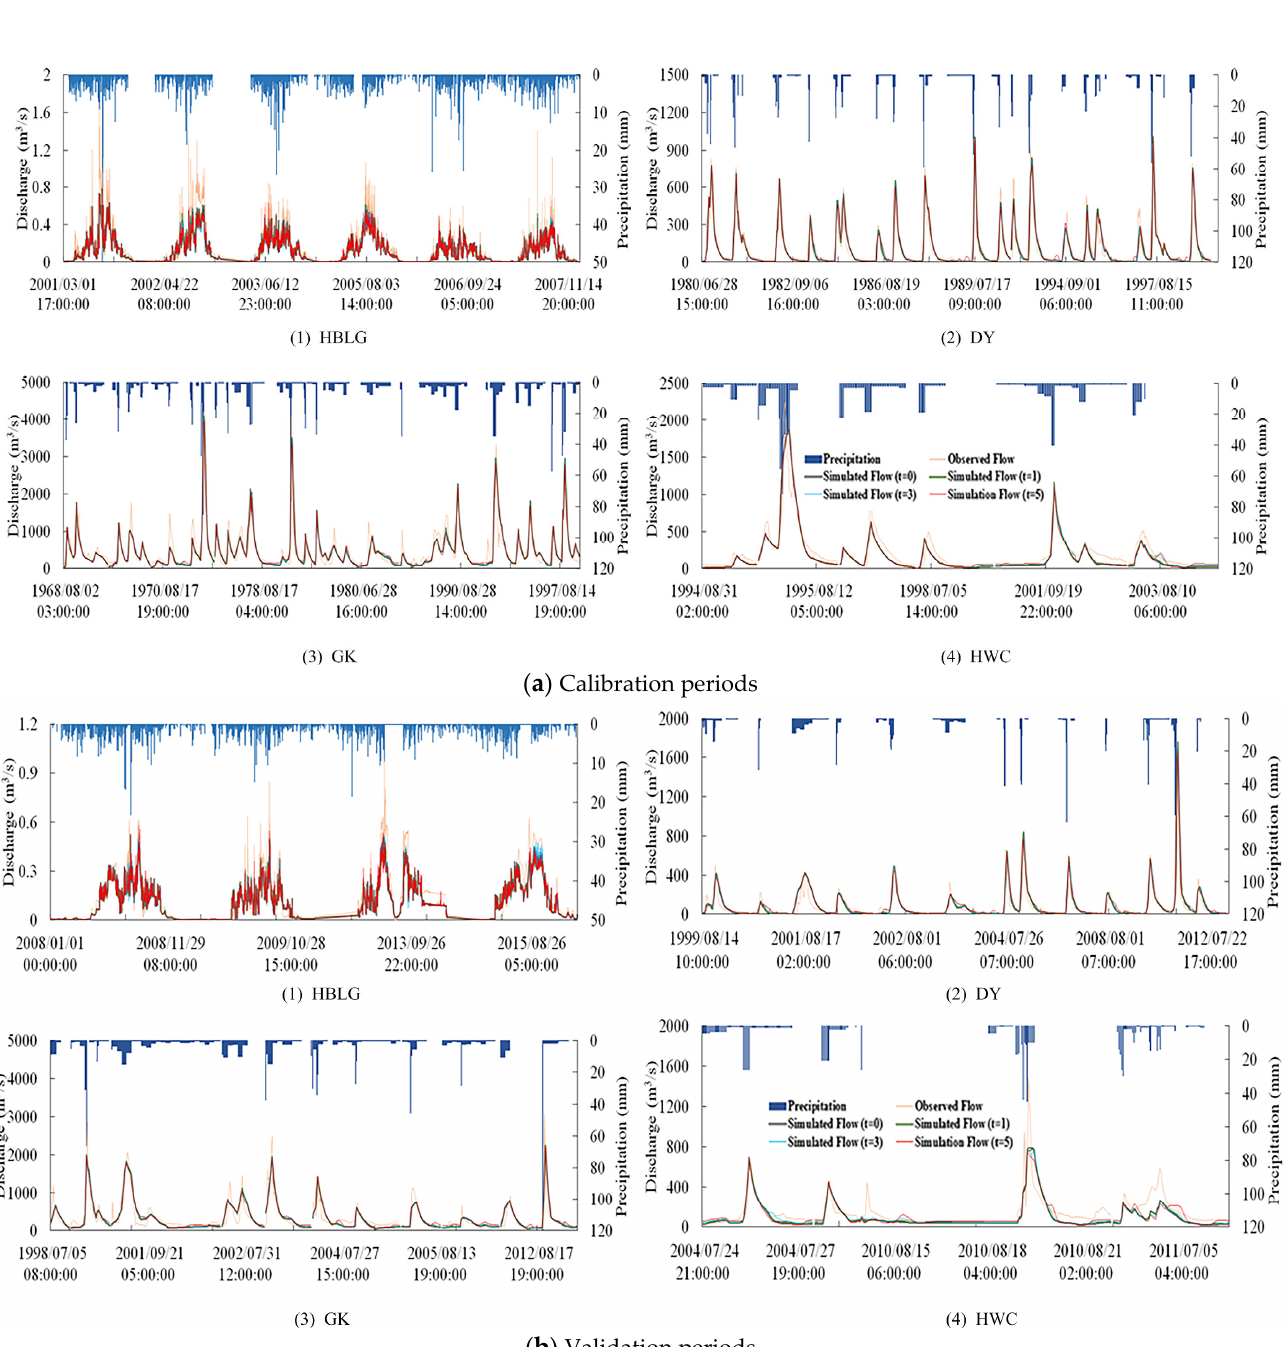
Figure 6. Processes of simulation and forecasting (t = 0, 1, 3 and 5). ( a ): Calibration periods; ( b ): Validation periods. For calibration, the NSE and R 2 values reached 0.8240 and 0.9252, respectively, for the runoff simulations, and the NSE values were above 0.7182 and the R 2 values were above 0.7759 for the flood simulations. The SVSMRG-SBS model was thus proved to be effective. For validation, the NSE and R 2 values reached 0.8241 and 0.9097 for the runoff simulations, while the NSE ranged from 0.5923 to 0.7467, and the R 2 ranged from 0.6669 to 0.8092 for flood simulations. For the scenario of 1, 3, and 5 h baseflow forecasting, the model performance declined when forecasting runoff processes, as is clear when the NSE and R 2 between the measured and modeled runoff decreased from 0.8216 to 0.8087 and from 0.9095 to 0.8871, respectively. Similar to the flood simulations, the NSE and R 2 values declined from 0.7414–0.5885 to 0.7429–0.5716 and from 0.8042–0.6547 to